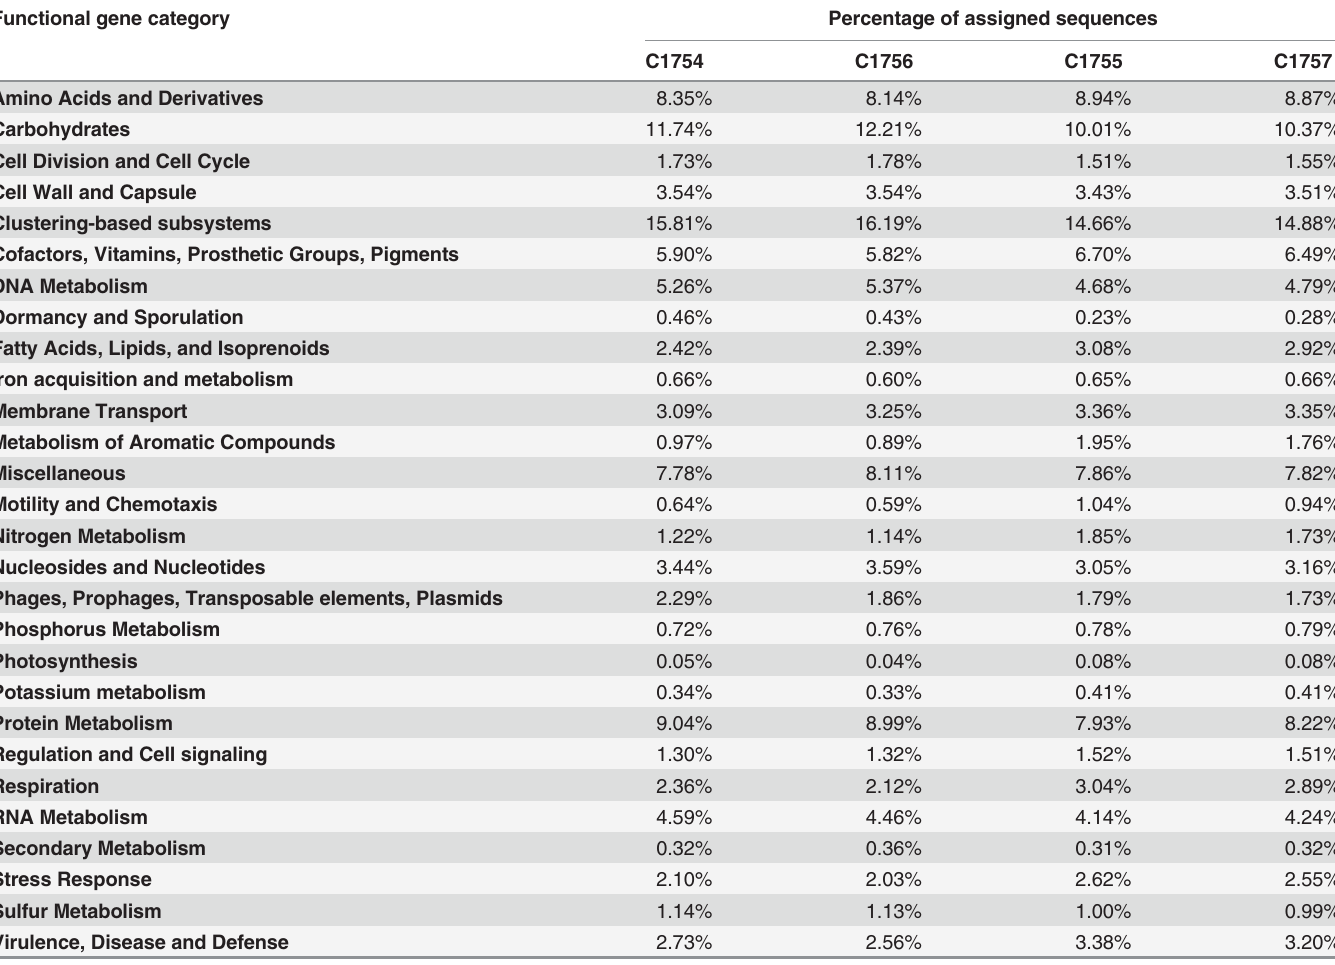
Table 1. Alphabetically ordered functional gene categories in the wastewater samples (MG-RAST SEED Level 1 Distribution). Functional gene